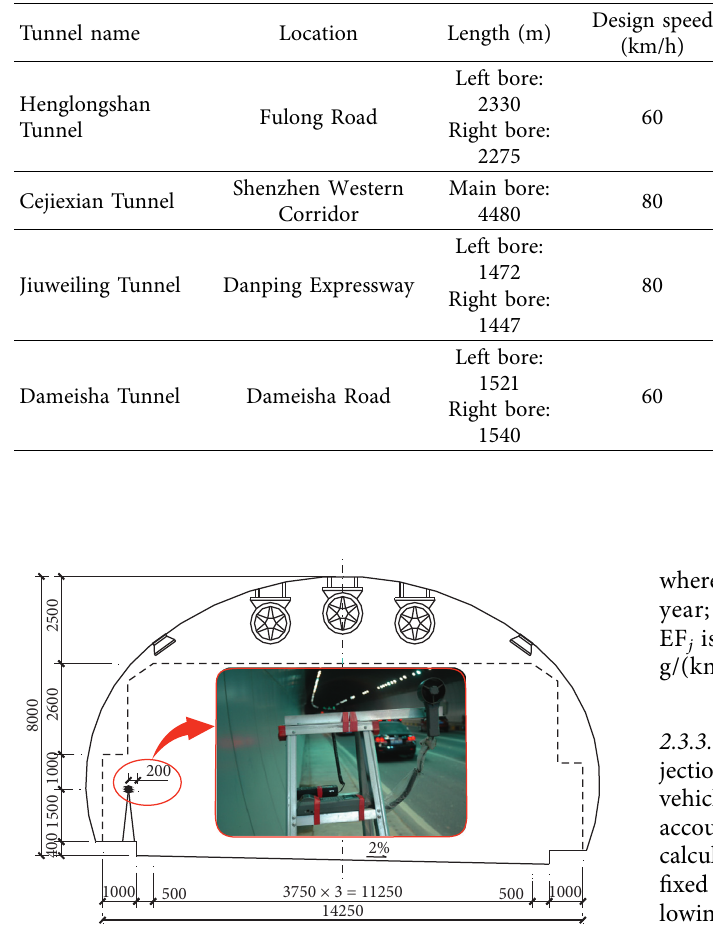
Figure 2: The monitoring station position in cross section (unit: